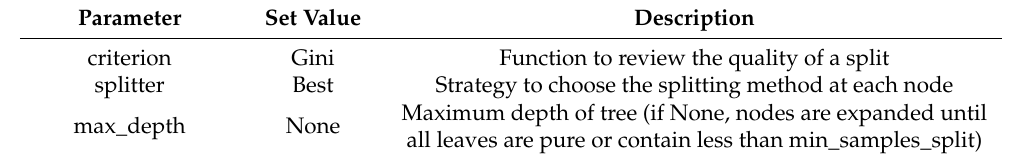
Table 10. Parameters of mechanism set for DT.